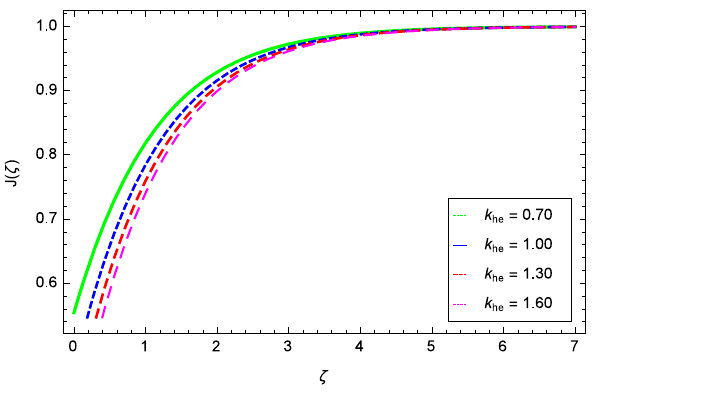
Figure 34. Effect of k he on concentration of chemical reaction J (ζ) .